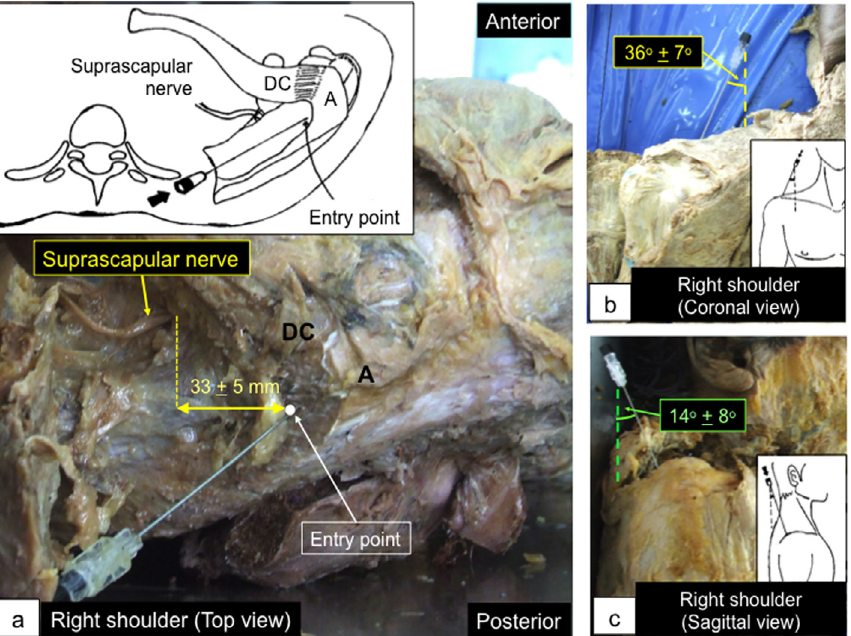
Figure 1. Cadaveric study of the superomedial protocol. (a) The entry point ( white dot ) was about 1 cm posterior to the distal clavicle and just medial to the acromion. It was about 3 cm away from the suprascapular nerve along the mediolateral axis. (b) and (c) The needle angle was 36 (cid:2) ± 7 (cid:2) lateral in the coronal plane (b) and 14 (cid:2) ± 8 (cid:2) anterior in the sagittal plane (c). A: acromion; DC: distal